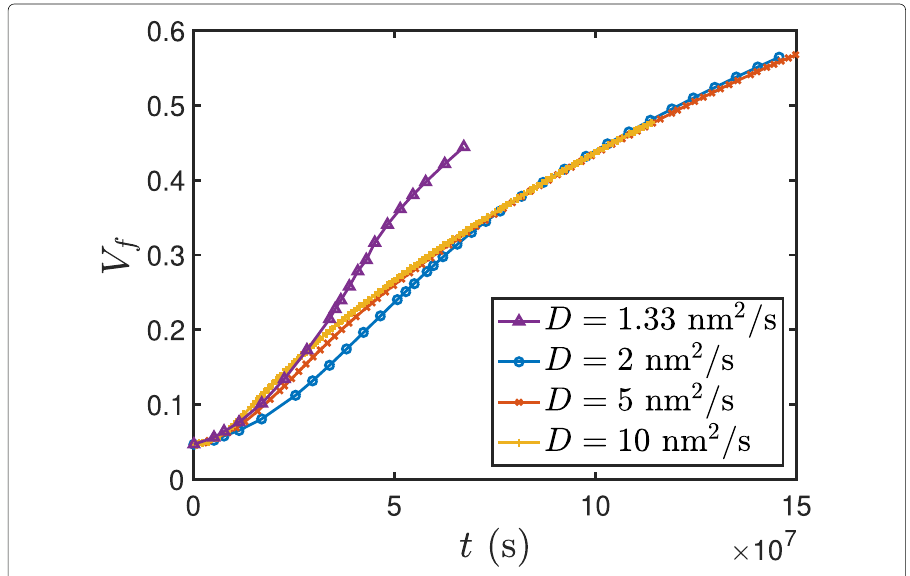
Fig. 3 Volume fraction of the bubble phase, V f , versus time for varying diffusivity (initial conditions of Configuration